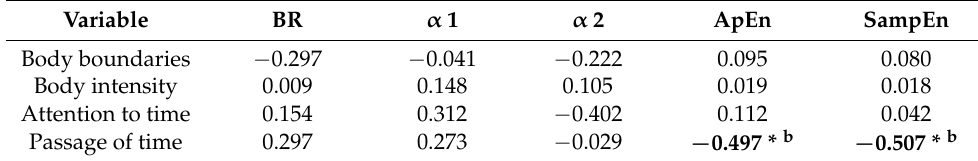
Table 6. Correlations between physiological variables, subjective time, and body boundaries during the meditation condition. Significant correlation coefficients marked in bold : * p < 0.05 (two-tailed); b = not significant after α correction.